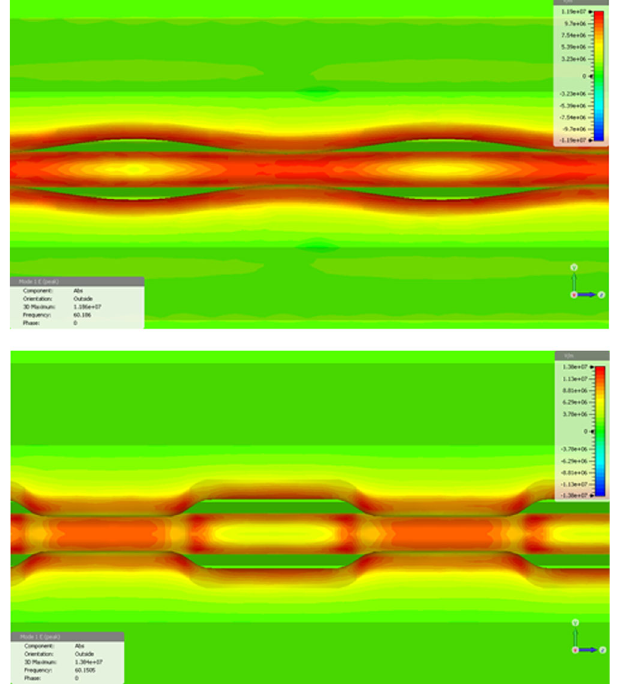
FIG. 20. Intervane electric field along the RFQ for the actual tuner’s configuration and the equivalent uniform tuner’s depth (3.5 cm).